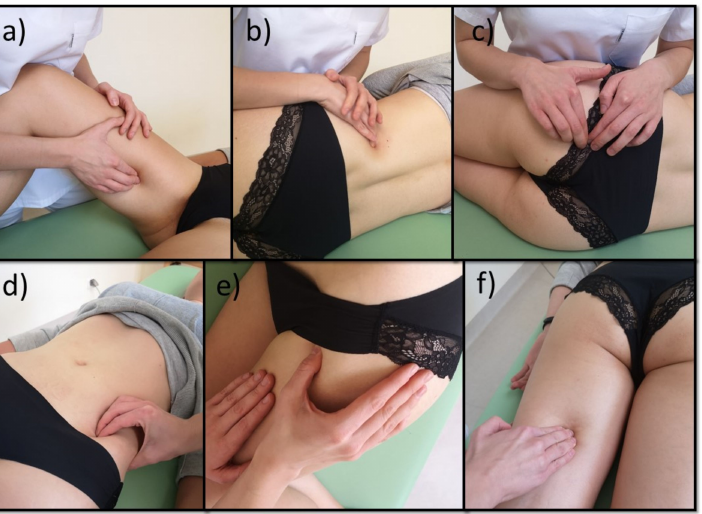
Figure 4. Therapy of tender points: ( a ) mm. adductors of the thigh; ( b ) mm. quadratus lumborum; ( c ) m. piriform; ( d ) m. iliopsoas; ( e ) m. tensor fasciae latae; ( f ) mm. hamstring.